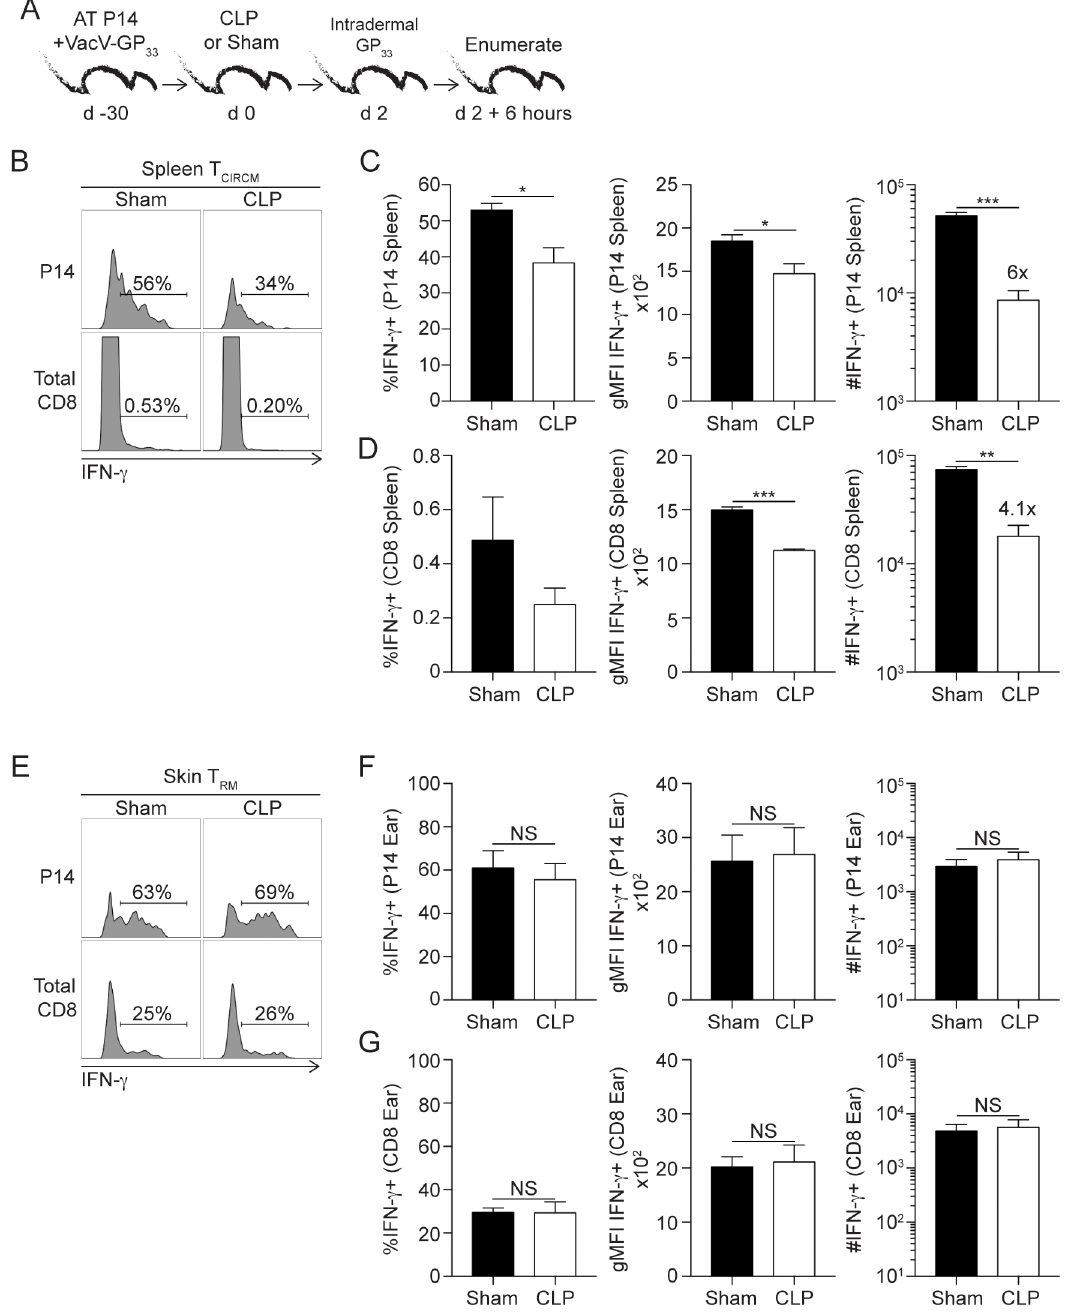
Fig 2. Skin CD8 T RM maintain Ag-dependent ‘sensing and alarming’ function after sepsis induction. (A) Experimental Design. 10 4 na ï veP14 CD8 T cells (Thy1.1) were adoptivelytransferred into C57Bl/6recipients (Thy1.2) followedby VacV-GP 33 infection of the left ear. After 30 days mice underwentCLP or sham surgery and two days later mice received50 μ gof GP 33-41 peptidevia intradermal injectionin the left ear. After 6 hours of in vivo peptidestimulation,mice receivedintravascular injectionof CD45.2mAb. Tissues of interest were harvestedthree minutes later. (B) Representative gating and frequency of IFN- γ producingP14 T CIRCM and total CD8 T cells in sham and CLP hosts. (C) Summary data of frequency and numberof P14 T CIRCM IFN- γ production.(D) Summary data of frequency and numberof total CD8 T cells IFN- γ production. (E) Representative gating and frequency of IFN- γ producingP14 and CD8 skin T RM in the left ear from sham and CLP hosts. (F) Summary data of frequency and numberof P14 T RM IFN- γ production. (G) Summary data of frequency and numberof total CD8 T RM IFN- γ production.Data are representative of five independentexperiments with at